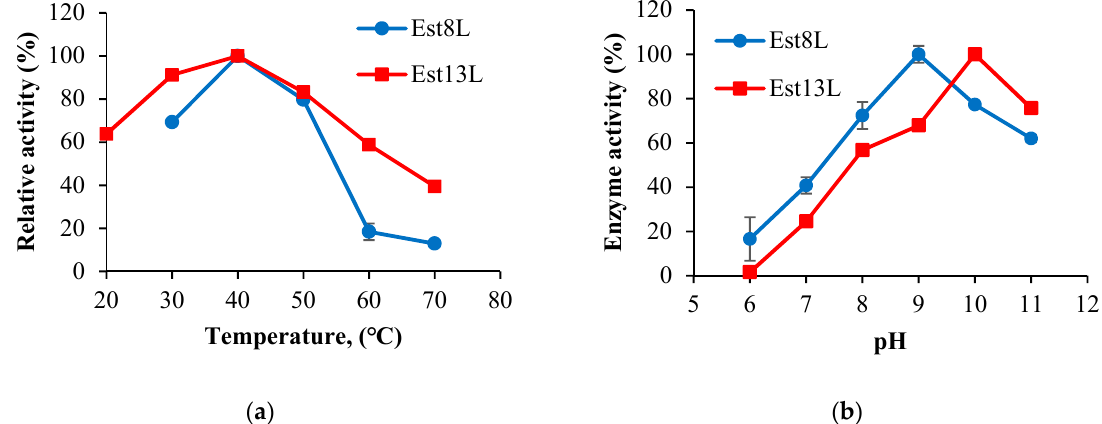
Figure 5. Optimum temperatures ( a ) and optimum pH values ( b ) of Est8L and Est13L.